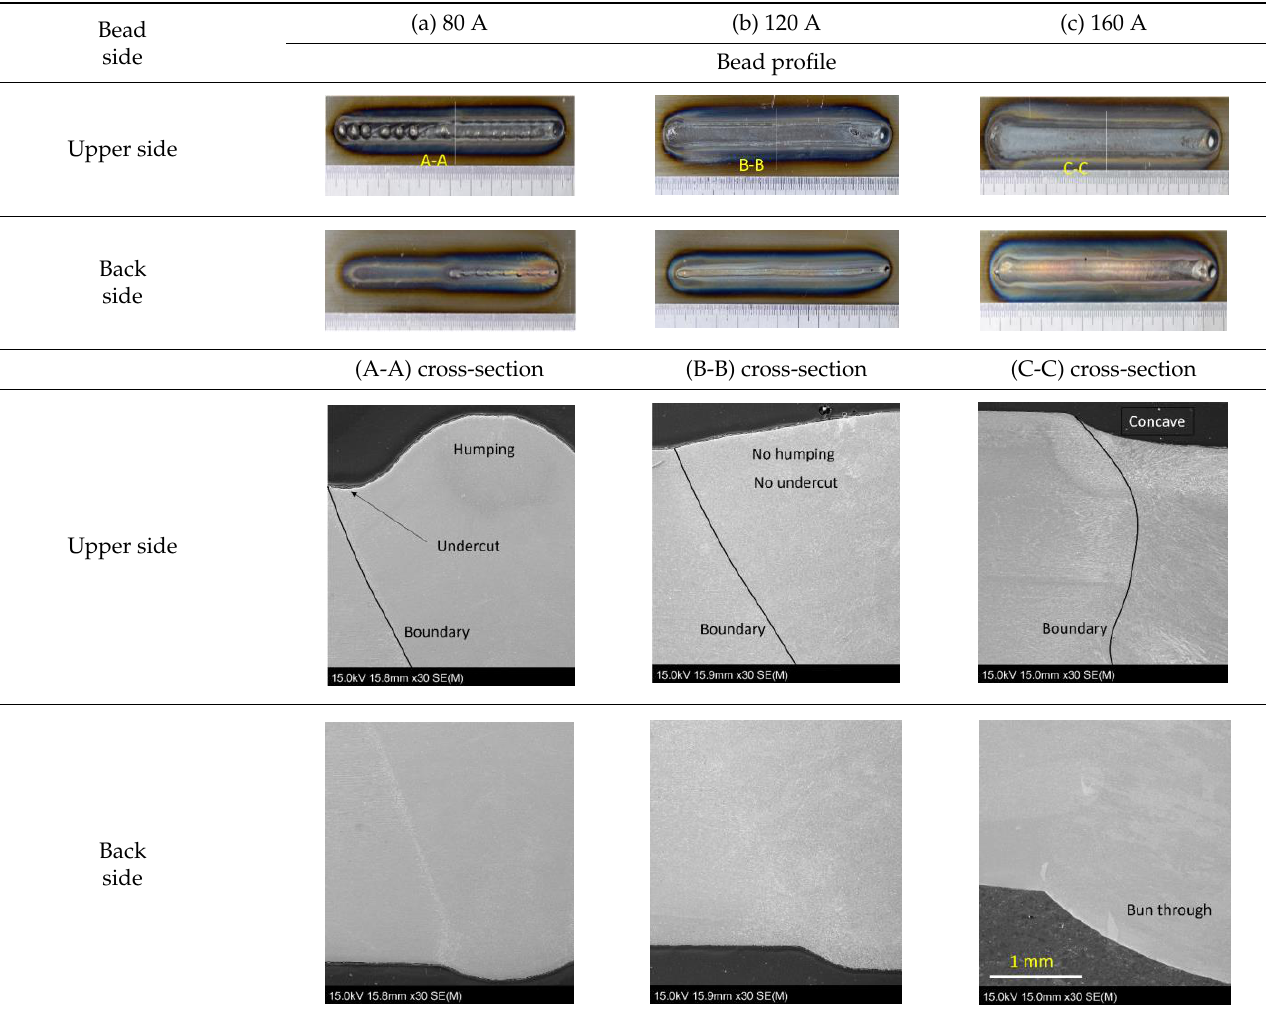
Table 1. A part of the cross-section of the weld bead and welding defects.